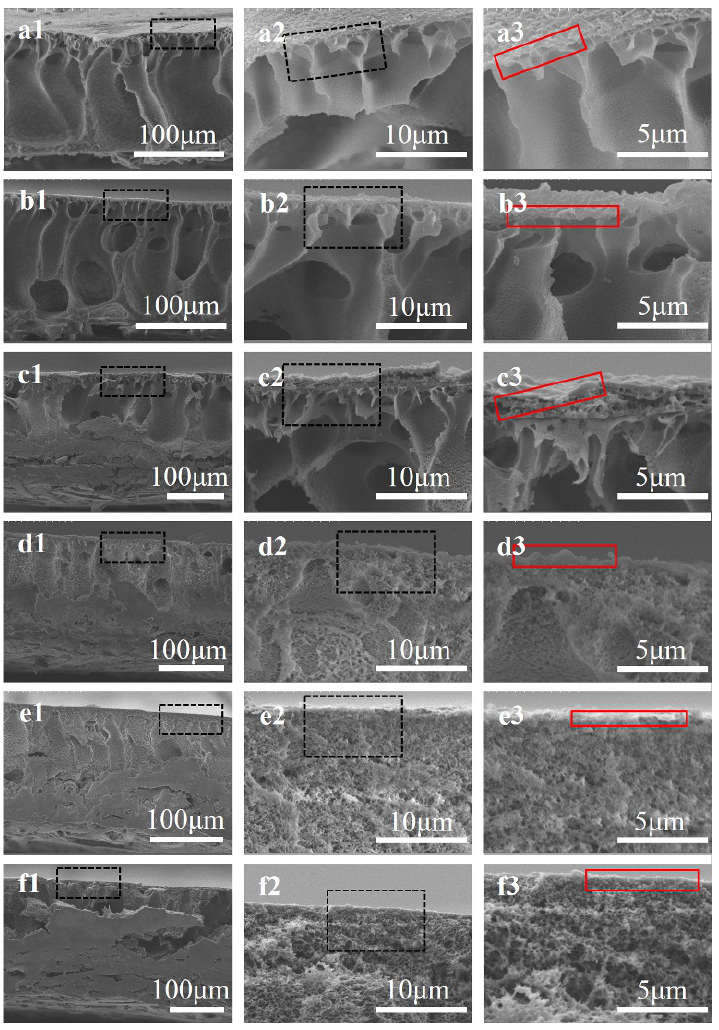
Figure 7. Cross-sectional SEM images of the polyamide TFC membranes with different supports: